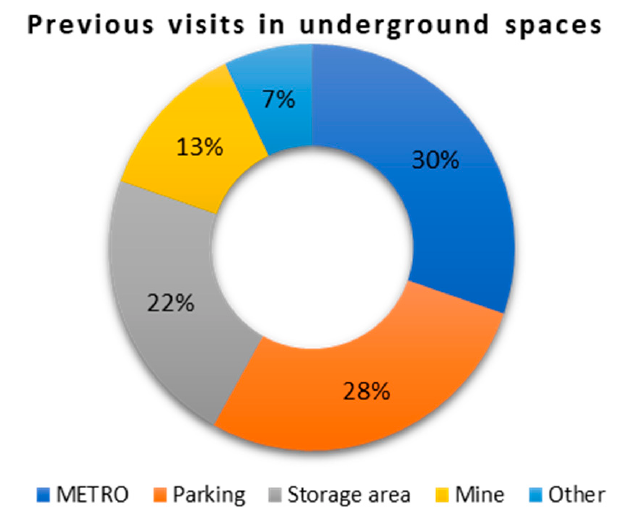
Figure 27. Previous visits in underground spaces.